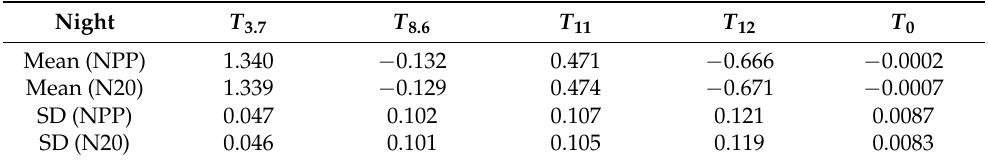
Table 1. Loads (partial derivatives averaged over full NPP and N20 missions) on all bands and on the first-guess SST in the nighttime NLSST Equation (2). Corresponding SDs are also shown. Night